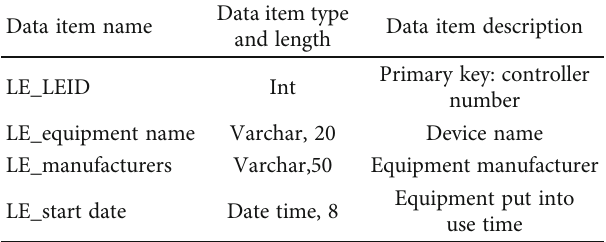
Table 2: Data structure of device information table.